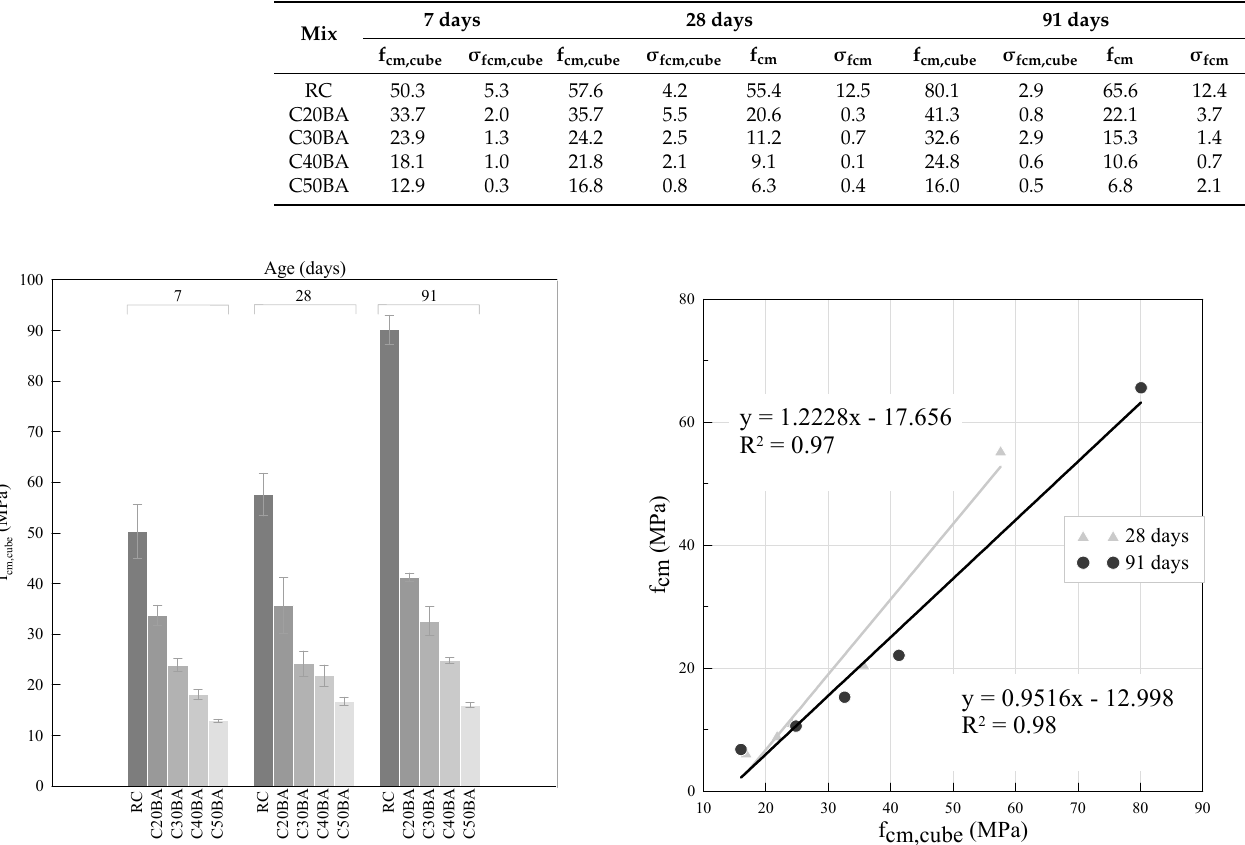
Figure 3. Compressive strength in cubes at 7, 28 and 91 days ( left ); Relationship between compressive strength in cubic and cylindrical specimens at 28 and 91 days ( right ).